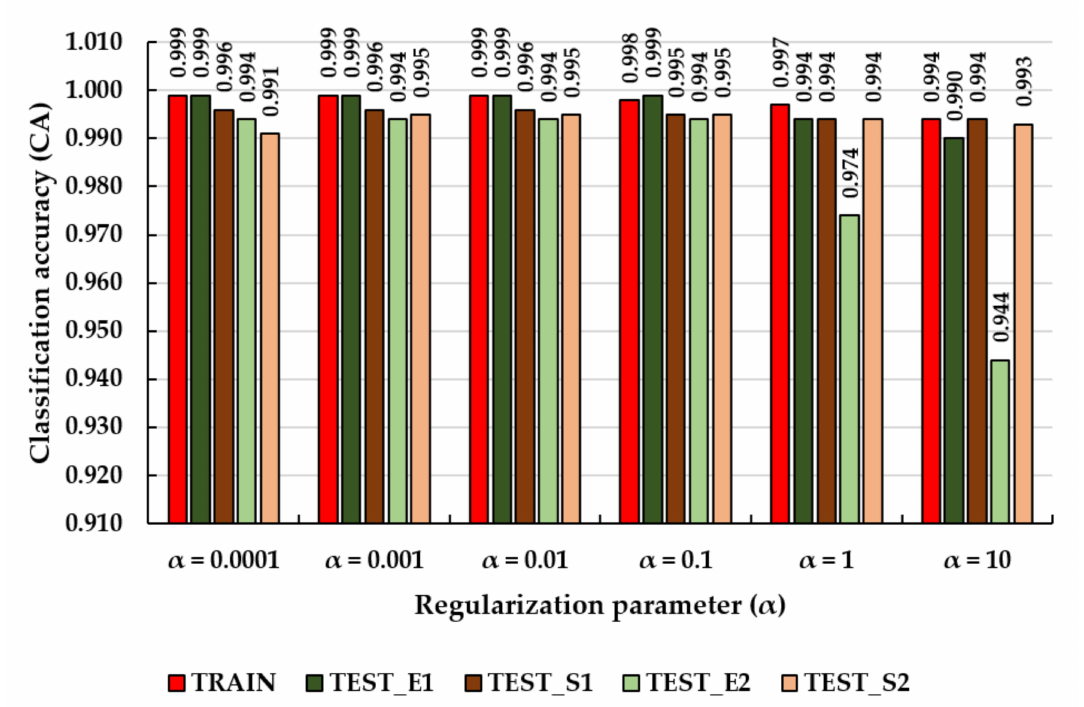
Figure 4. Classification accuracy scored at the training (TRAIN) and testing (TEST_E1, TEST_S1, TEST_E2, TEST_S2) phases, as a function of the value of the regularization parameter ( α ).